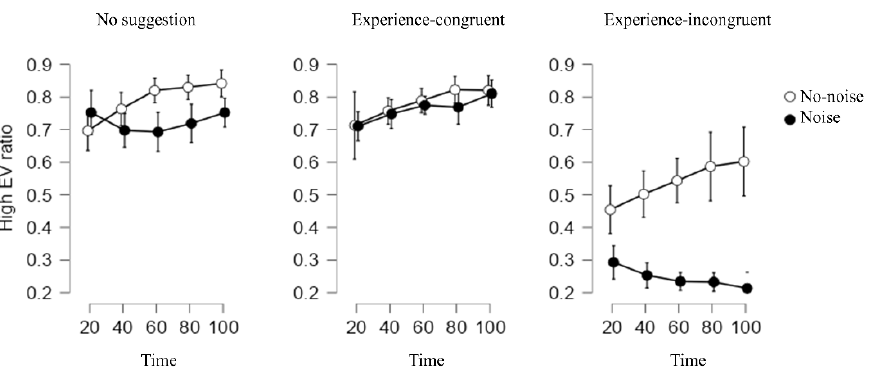
Figure 2. High-EV ratio in each condition of Study 1.